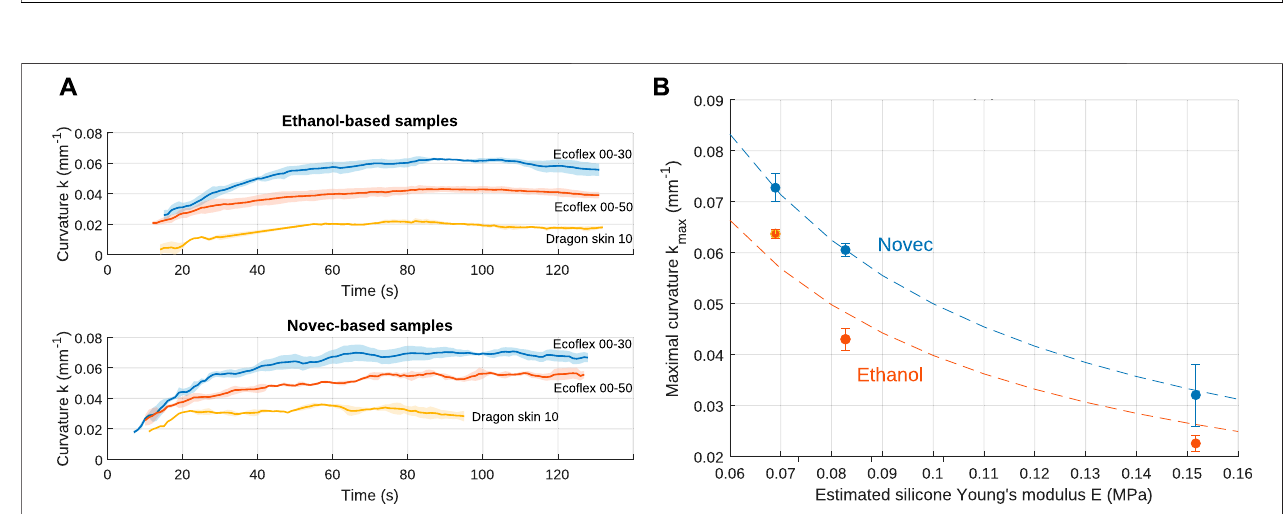
FIGURE 7| In fl uence ofthe elastomer materials on the bending of bilayer structures. The inextensible paper layer ison the right side of the sample. The best- fi tting circle is in red.